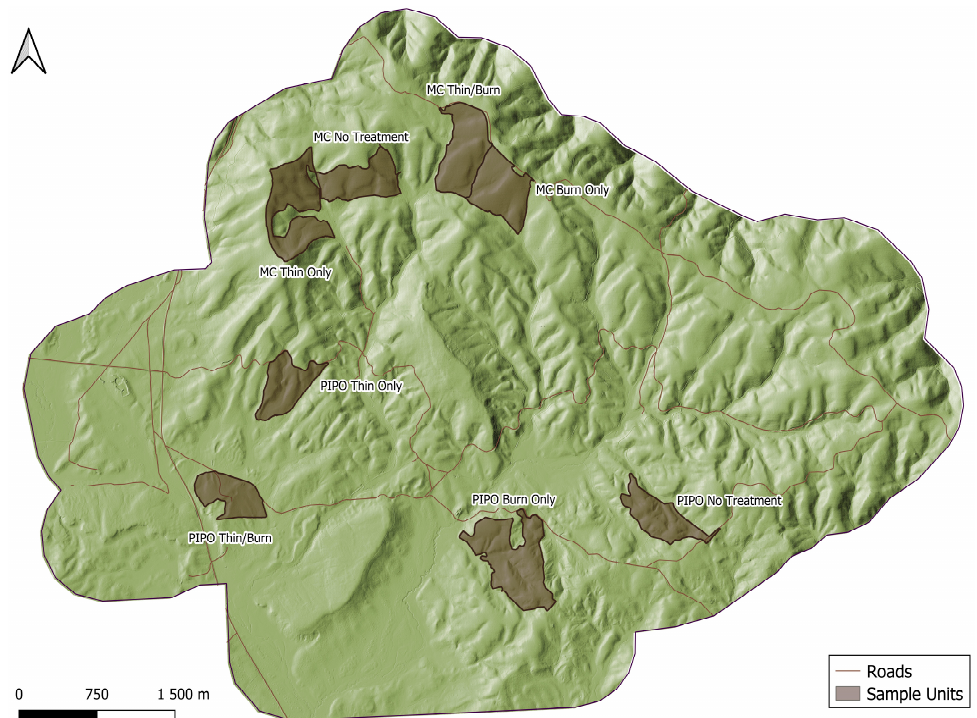
Figure 3. Sample units: randomly selected treatment and no-treatment units in ponderosa pine (PIPO) and mixed conifer (MC) forest types from the study area used to demonstrate the LiDAR-based assessment methods. Malheur National Forest near John Day, OR,